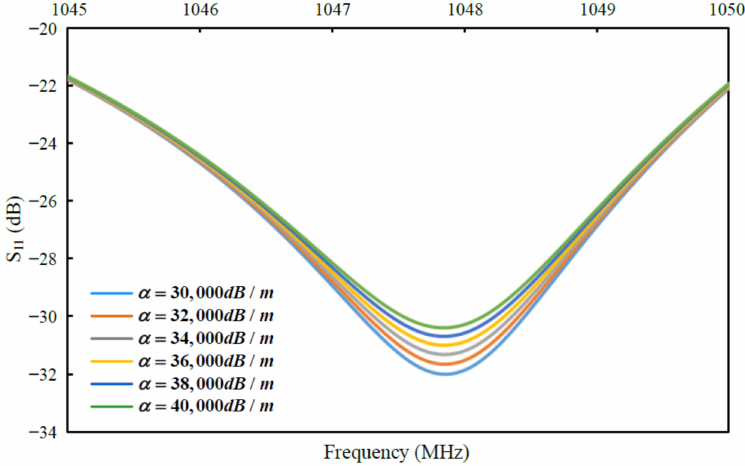
Figure 2. Simulation results of the response of S 11 with the change in attenuation factor α